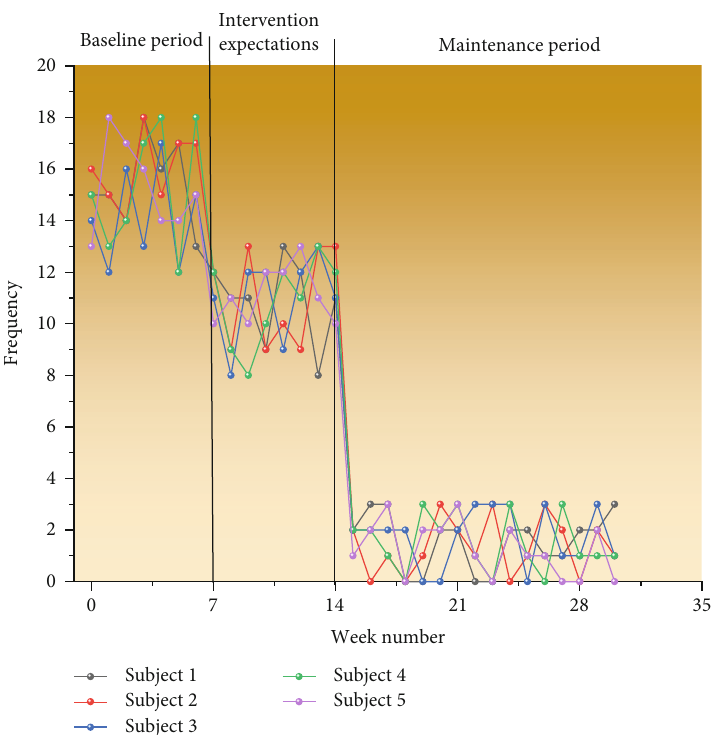
Figure 9: Graph of the number of emotional behaviors occurring with piano playing